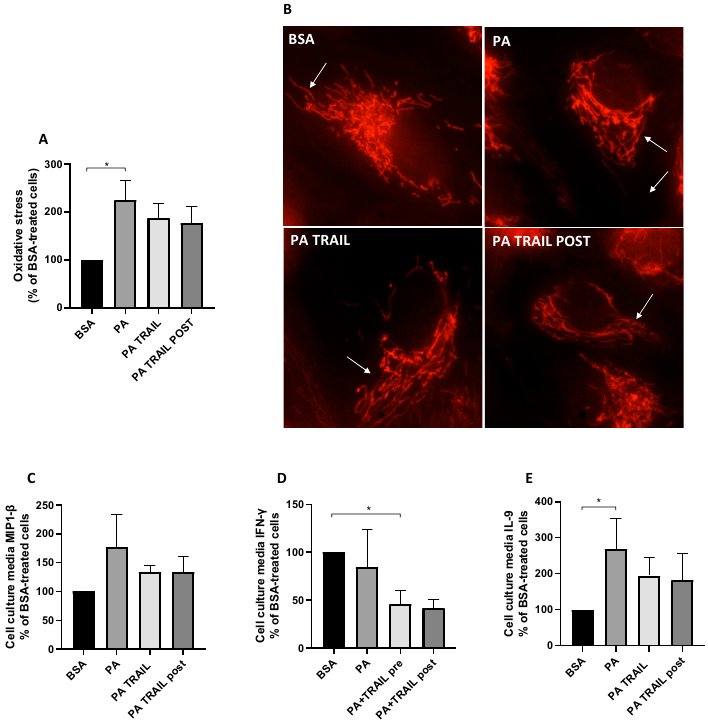
Figure 7. Effect of tumor necrosis factor (TNF)-related apoptosis-inducing ligand (TRAIL) on oxidative stress, mitochondrial dynamics and inflammation in the recovery experiments. ARPE-19 reactive oxygen species generation ( A ), representative images of ARPE-19 mitochondria stained with MitoTracker TM Red CMXRos ( B ) and MIP 1- β ( C ), IFN- γ ( D ), as well as IL-9 ( E ) secretion